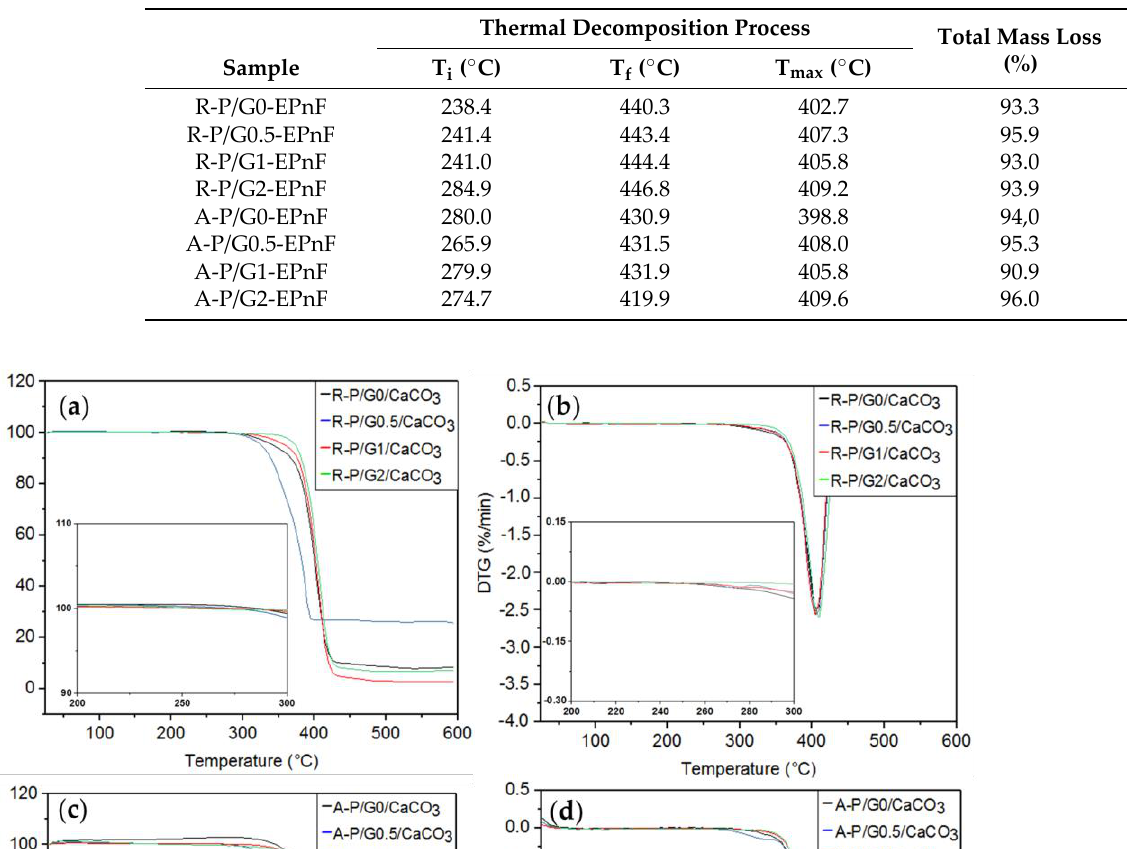
Table 6. TGA of R-P/G/CaCO 3 -EPnF and A-P/G/CaCO 3 -EPnF hybrid meshes. Table 6. TGA of R‑P/G/CaCO 3 ‑EPnF and A‑P/G/CaCO 3 ‑EPnF hybrid meshes.